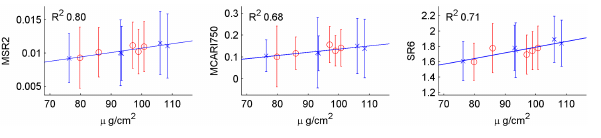
Figure 6. Correlation of spectral index and laboratory measure- ment for combined M2_1 and M3_1 data. Left: MSR2; middle: MCARI750; right: SR6. Blue x: M3_1; red circle: